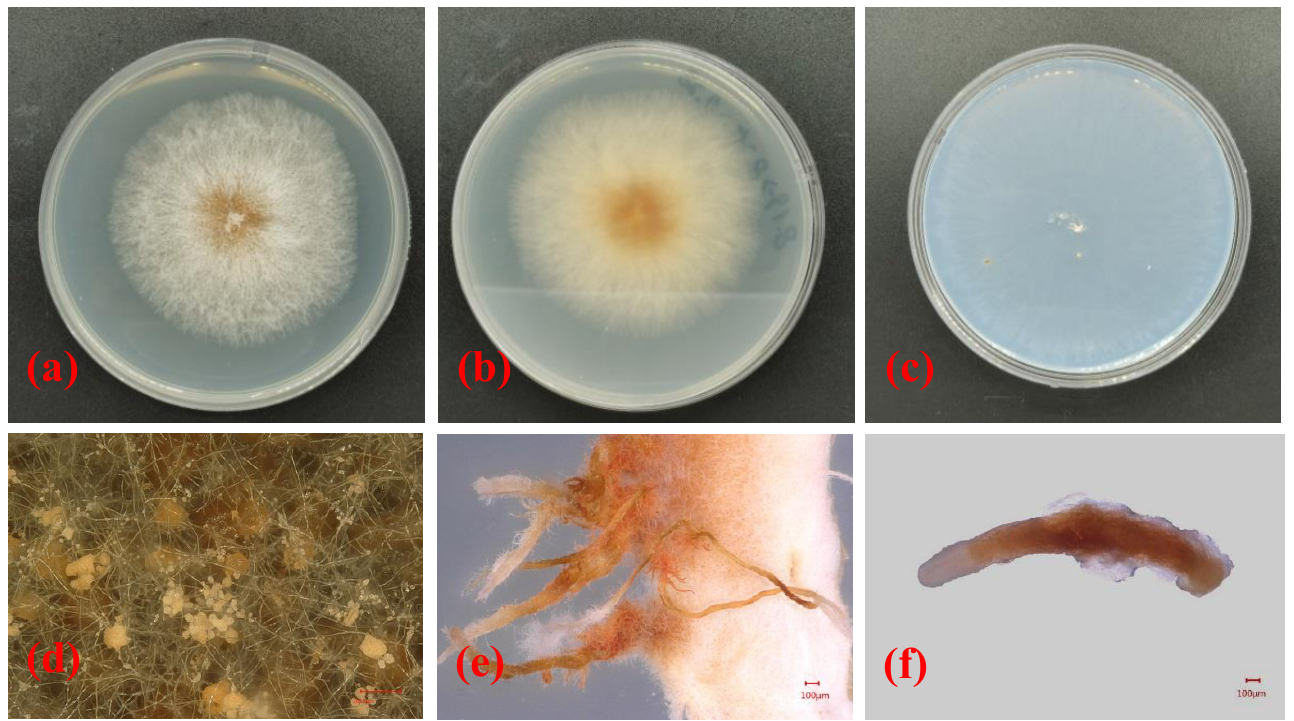
Figure 2. Morphological structures and cultural characteristics of Nectria pseudotrichia. ( a , b ) Upper and reverse sides of colonies on PDA, respectively; ( c ) upper side of colony on SNA; ( d ) conidial masses produced on PDA; ( e , f ) synnemata produced on PDA and SNA, respectively.